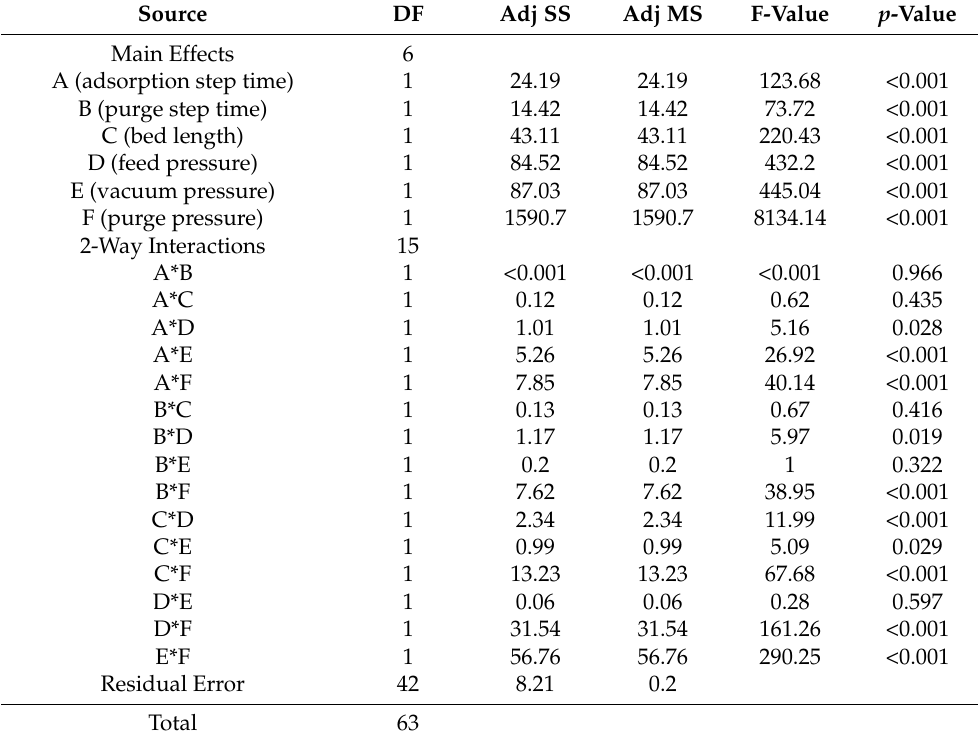
Table 14. The ANOVA table for the top product CH4 purity. * indicate the interaction between two factors.